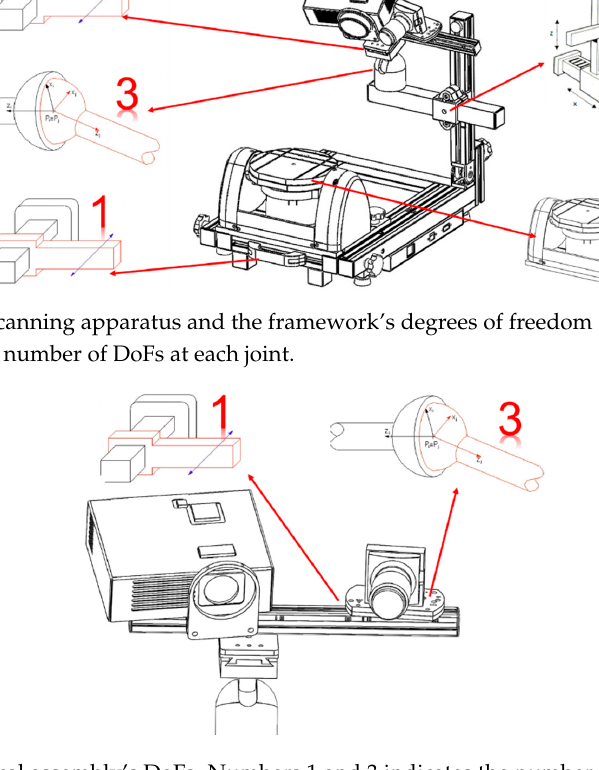
Figure 2. The optical assembly’s DoFs. Numbers 1 and 3 indicates the number of DoFs at each joint.